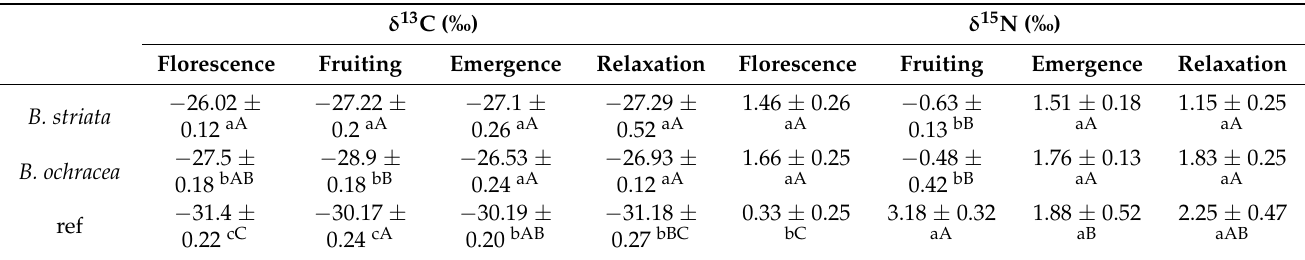
Figure 6. Overview of δ 13 C and δ 15 N values of two Bletilla species and autotrophic reference plants (ref) at four different phenological stages. ( A ) Florescence, ( B ) Fruiting, ( C ) Emergence, ( D ) Relaxation. Table 1. Comparison of δ 13 C and δ 15 N values (mean ± SE) among different species at each phenological stage and different phenological stages for each species.